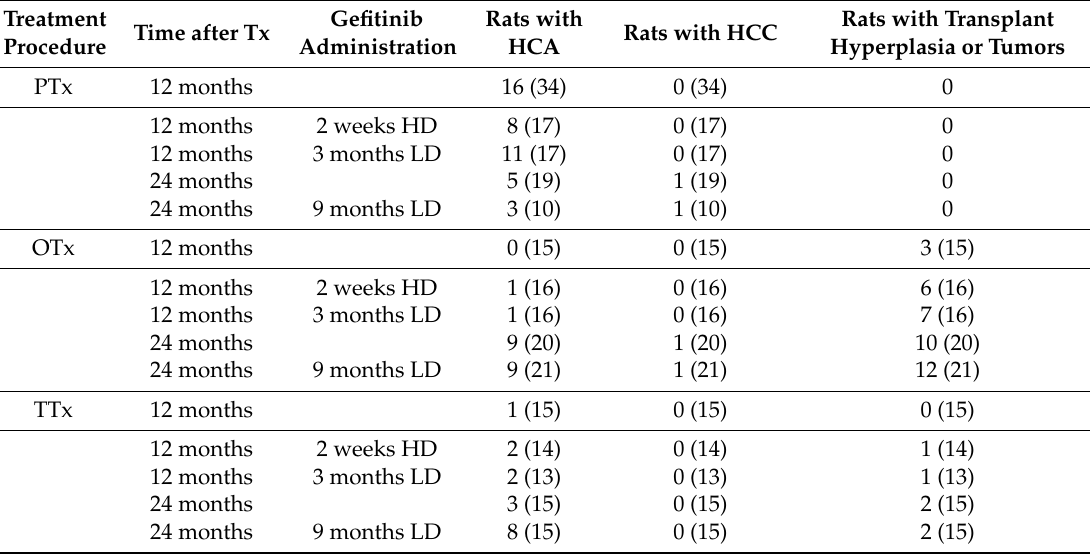
Table 3. The effect of gefitinib treatment on the frequency of hepatocellular tumors in hormonal